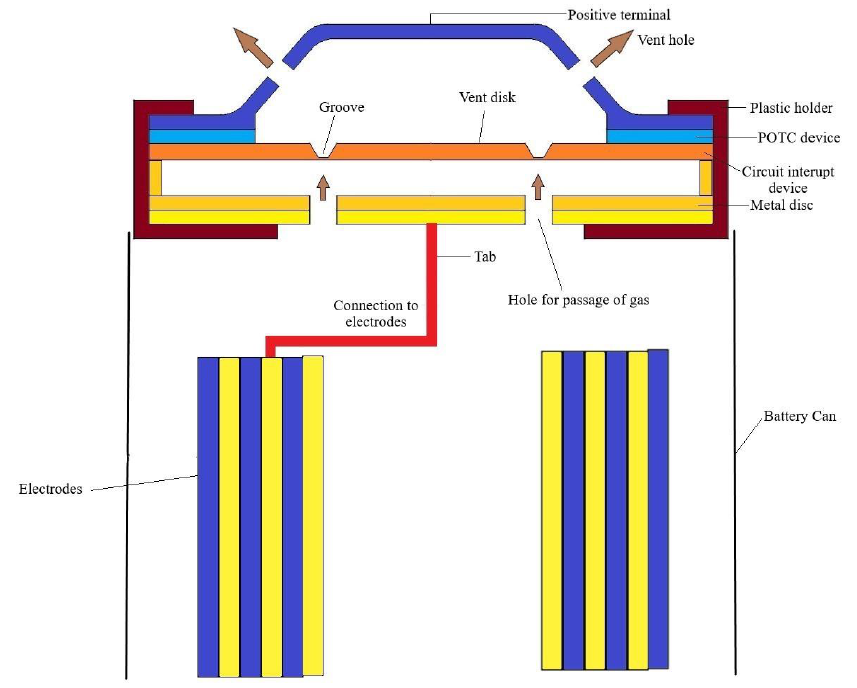
Figure 18. The vent holes and POTC device in the assembly of a Li-ion cell. Reprinted from ref.